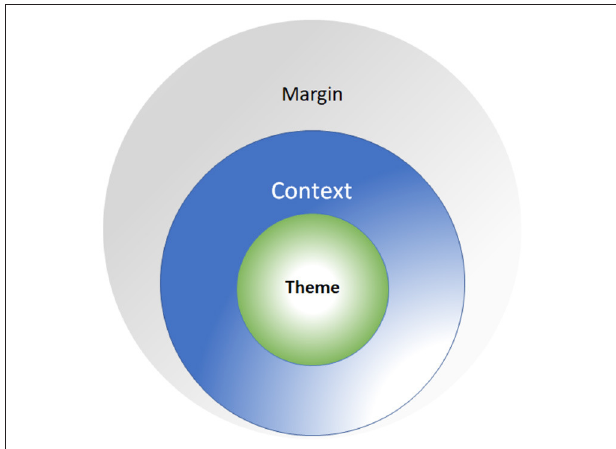
FIGURE 3 | Simplified model of Arvidson’s interpretation of Gurwitsch’s account of the field of consciousness.